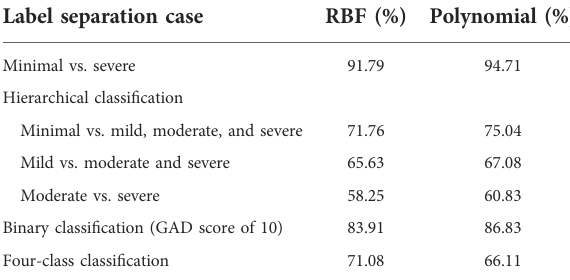
TABLE 6 Alternative kernels classi fi cation per test case for the second phase of COVID-19. Label separation case